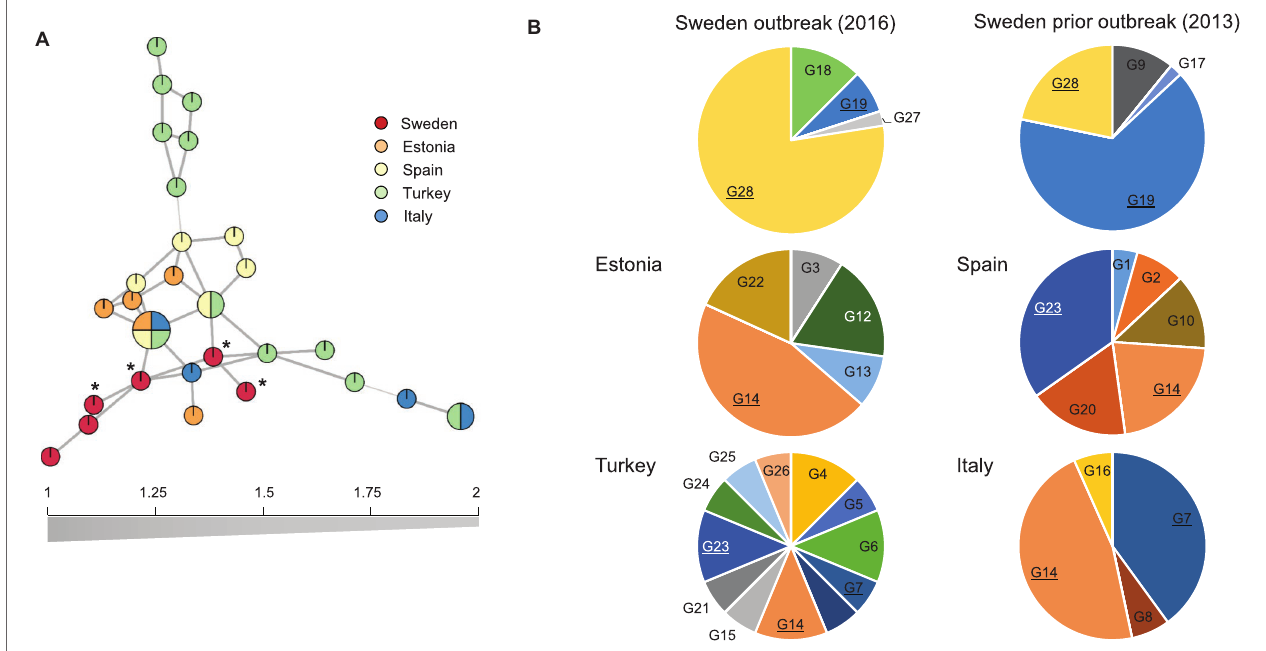
FIGURE 2 | Minimum spanning network among D. sapinea haplotypes in Europe (A) . Haplotypes from the outbreak area are marked with an (*). Pie charts with relative proportion of haplotypes among populations (B) . Underlined haplotypes are found in more than one location.